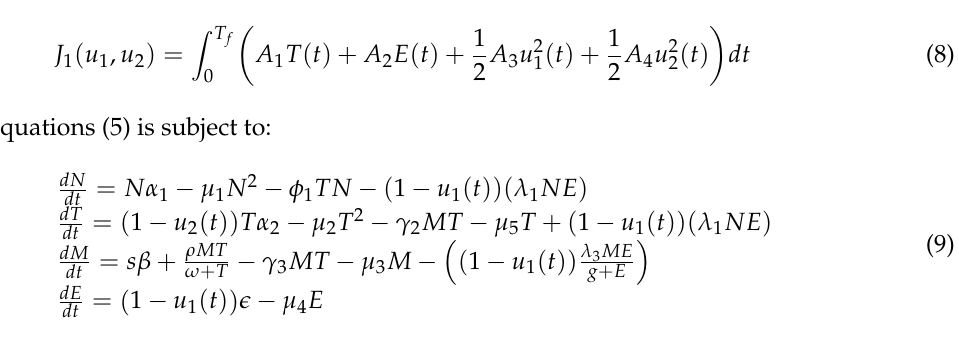
Figure 2. PRCCs of homogeneous model parameters with the tumor cells as the baseline variable. All parameter values were varied in 25 % of their baseline values in Table 1. The most sensitive parameters are shown to be P − values of s , γ 2 , µ 3 and ρ are less than